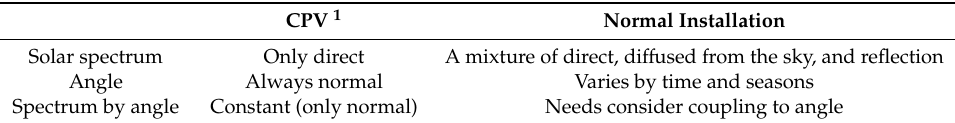
Table 1. The difference in performance modeling between concentrator PV and standard installation.